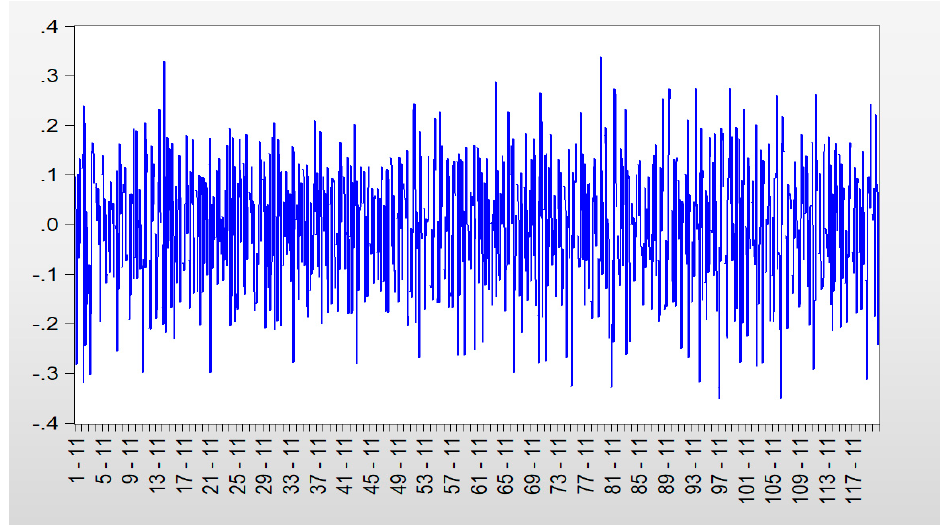
Figure 7. The influence of competitiveness and voter ratio of major shareholder holders on the quality CGS before the COVID-19 pandemic. Source: Author’s computations.